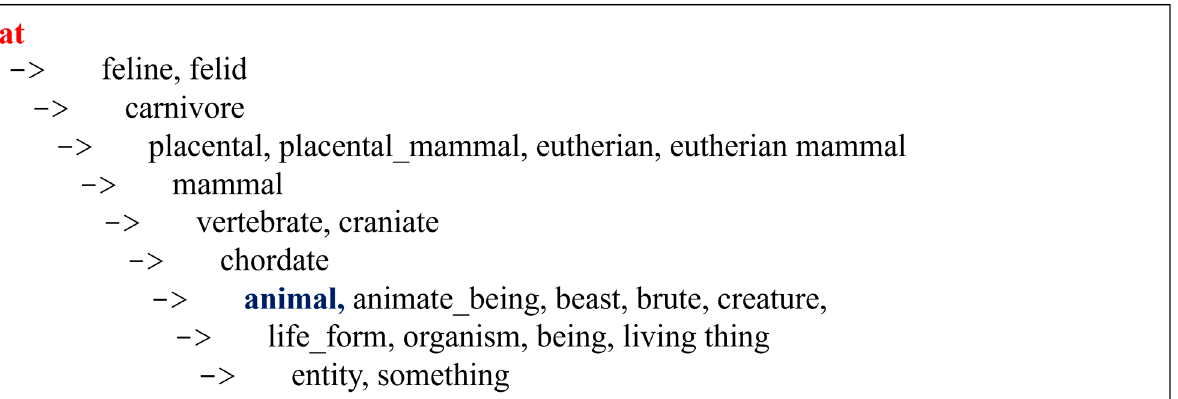
Figure 1. Complete hierarchical tree of the lexical entry “cat” as derived from WordNet. The Semantic Depth Index (SDI) of the specific term “cat” (in red) corresponds to 10, i.e., the number of nodes from the root term “entity” to the term “cat”. The SDI of the generic, superordinate term “animal” (in blue) corresponds to 3.